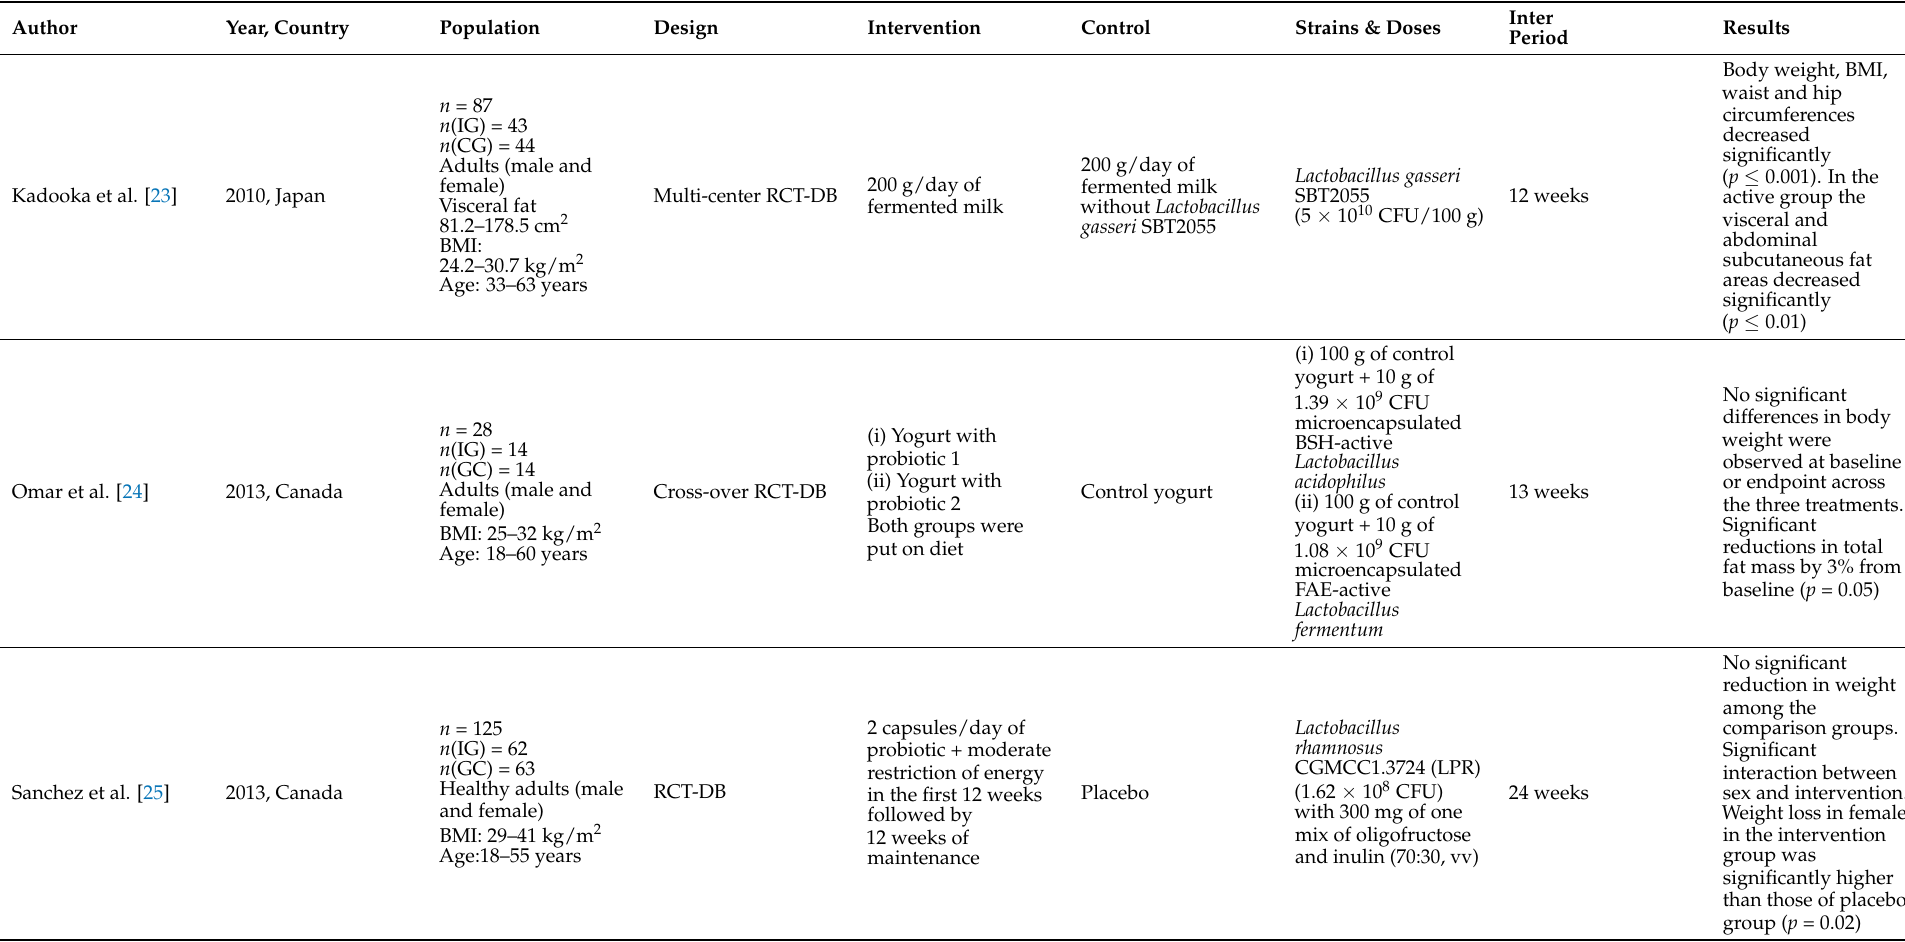
Table 1. Detailed summary of the selected studies included in the